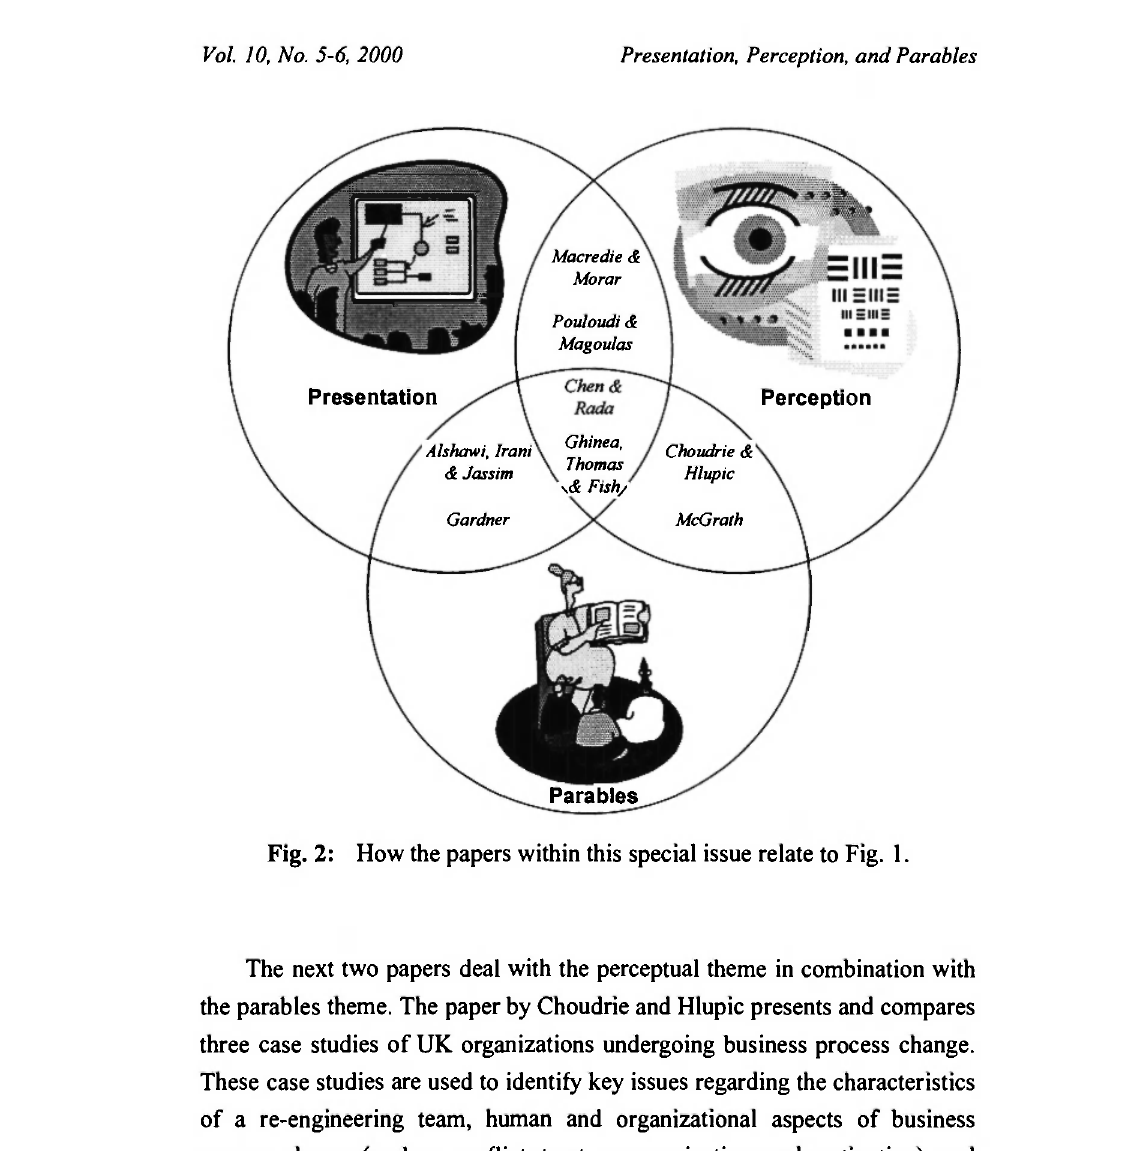
Fig. 2: How the papers within this special issue relate to Fig. 1